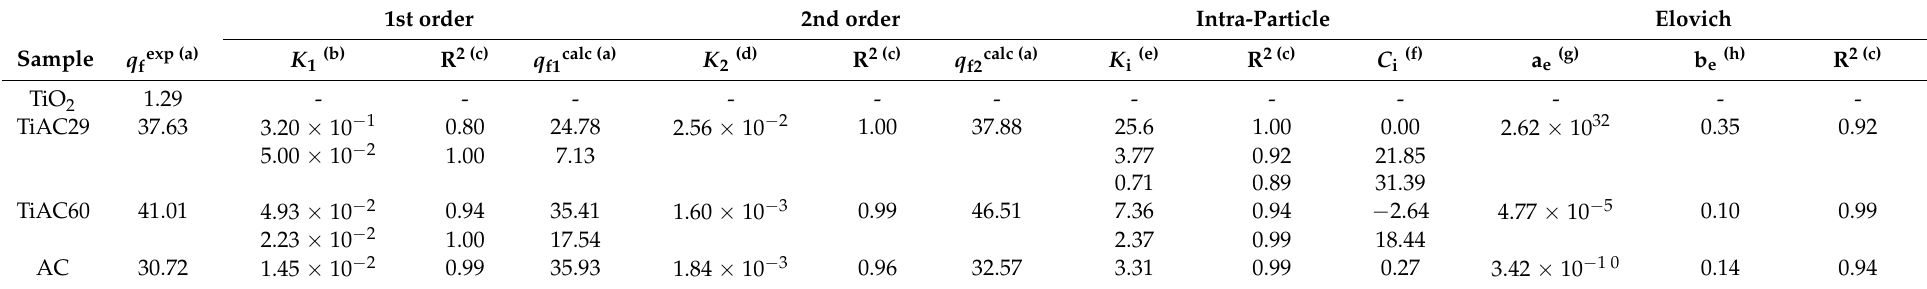
Table 4. Adsorption kinetics data ( experimental conditions: q max is 45–50 mg/g, [MB] = 25.0 mg dm − 3 , V = 20 cm 3 , adsorption time = 90 min, m adsorbent ~10